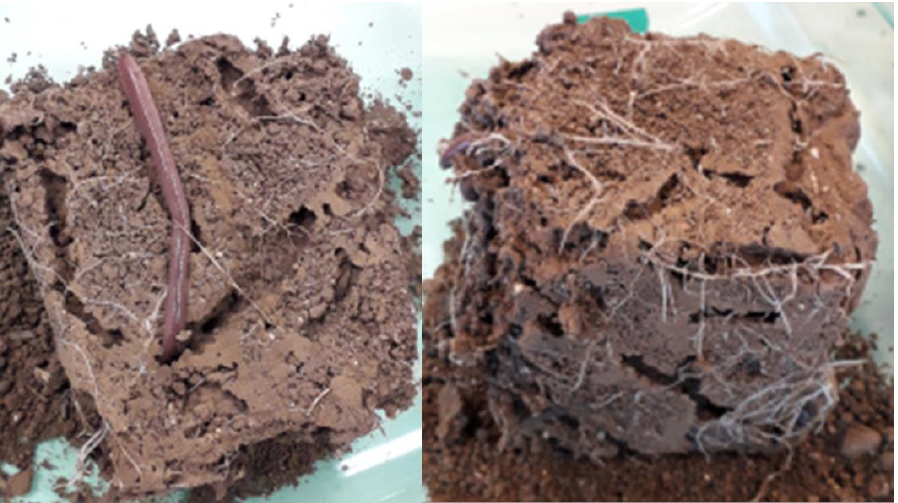
Figure 1. Representative pictures of soil collected in pots at the plant harvest illustrating the intense burrowing activity of